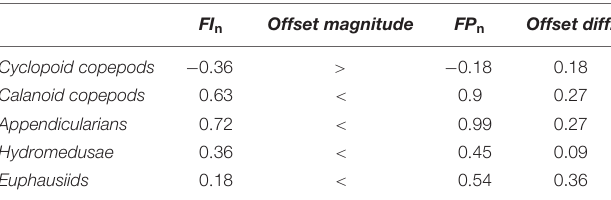
TABLE 2 | Cross-correlation lag/vertical offset values in density (kg/m 3 ) coordinates between FI n , FP n , and each canonical profile for zooplankton groups. FI n Offset magnitude FP n Offset